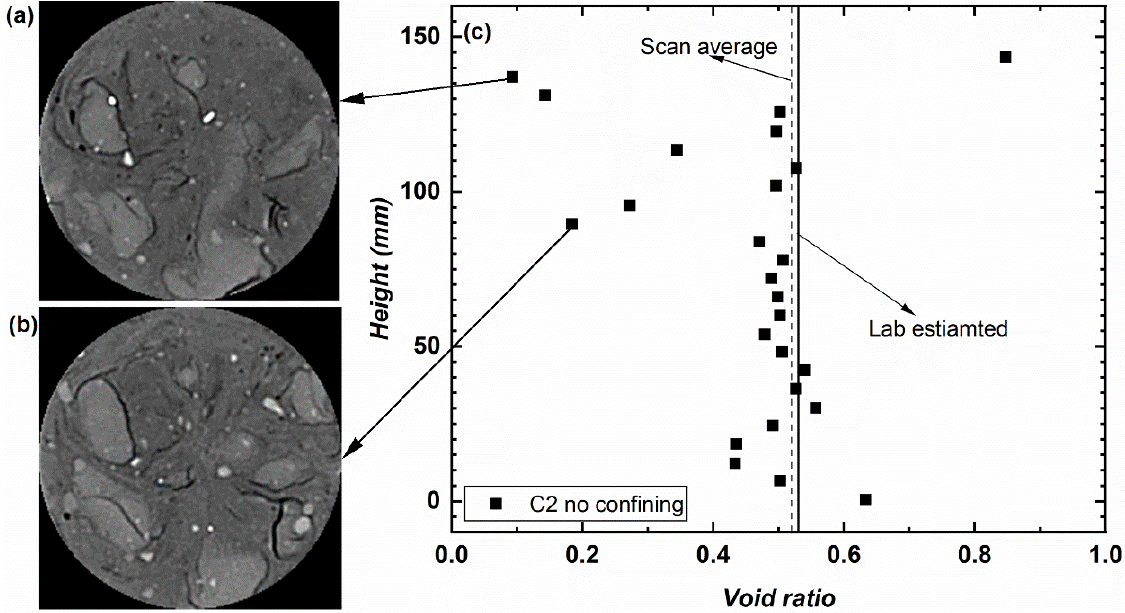
Figure 12. Void ratio calculated from CT scans: ( a , b ) cross-section slices from different locations and ( c ) void ratio distribution along the sample (adapted from [9]).